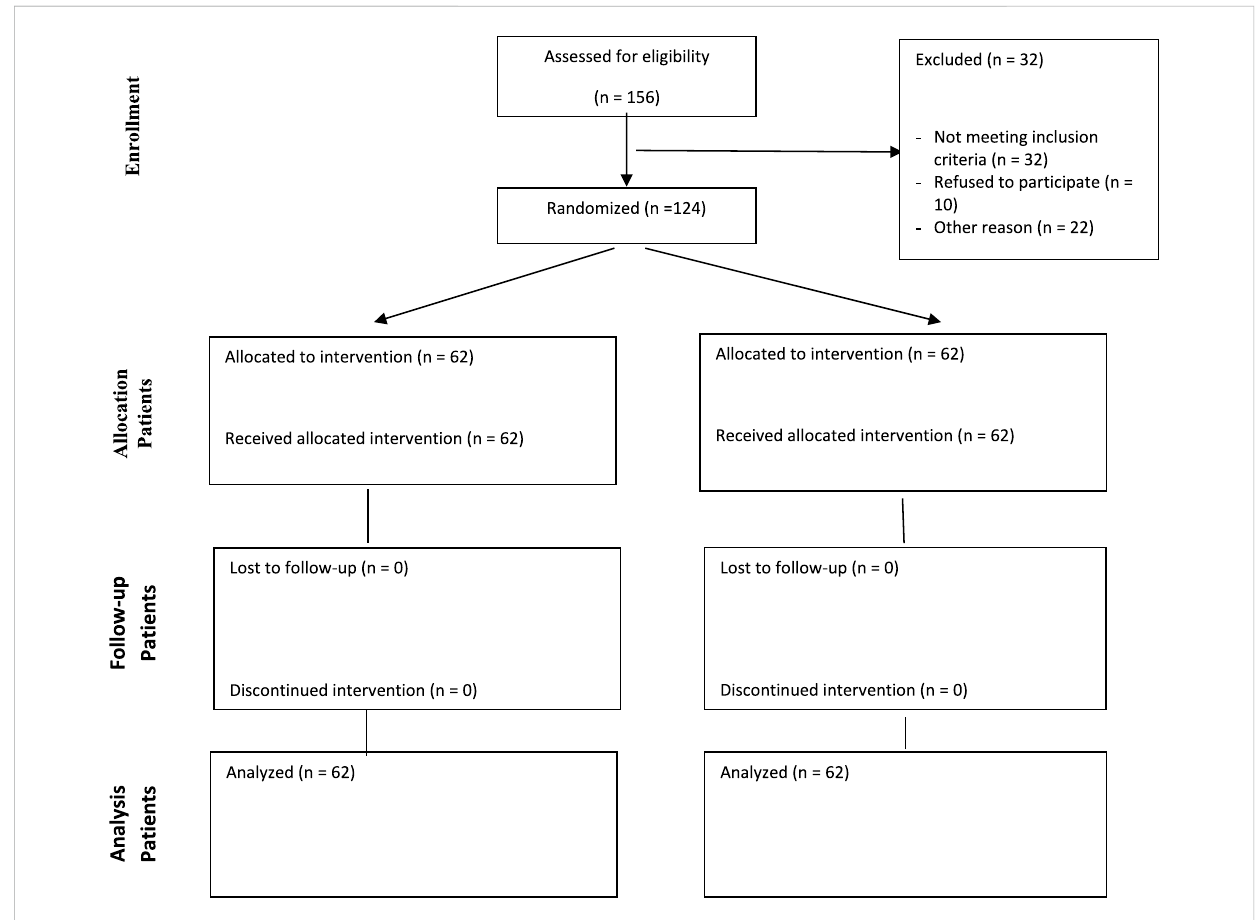
FIGURE 1 CONSORT diagram showing screening, randomization, and analysis of the participants. The whole participants were included in the